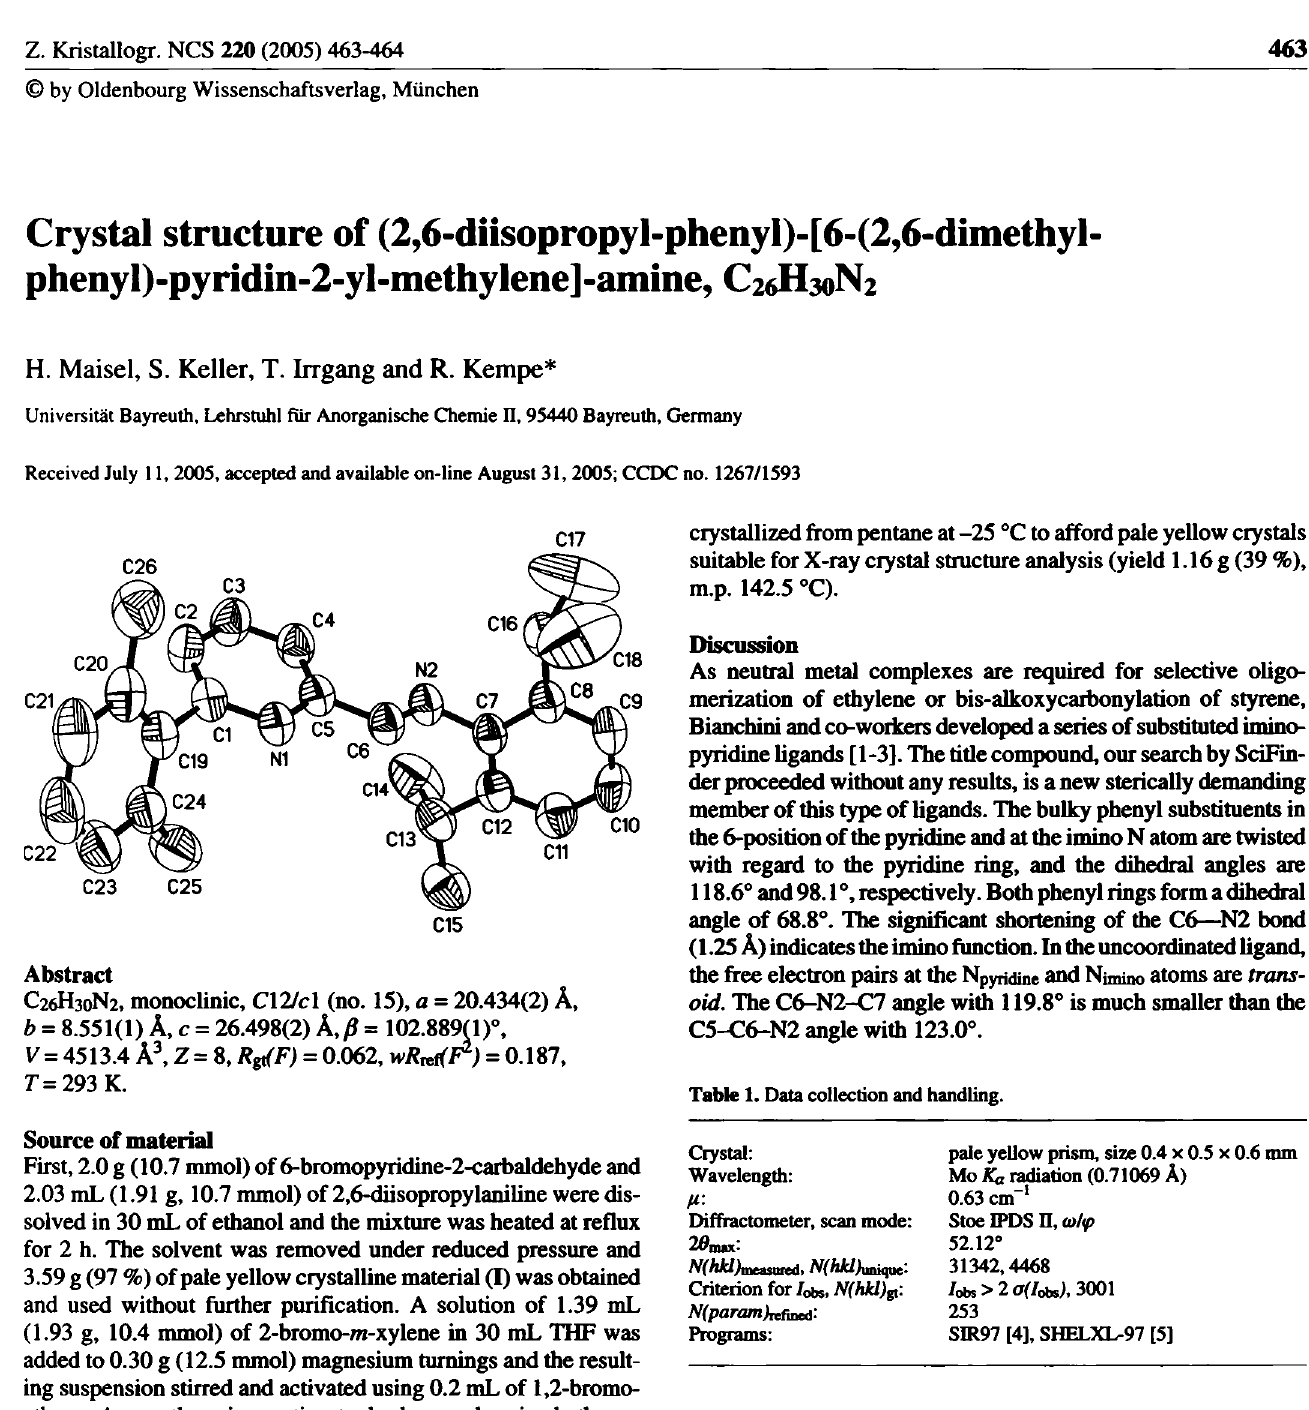
Table 2. Atomic coordinates and displacement parameters (in A 2